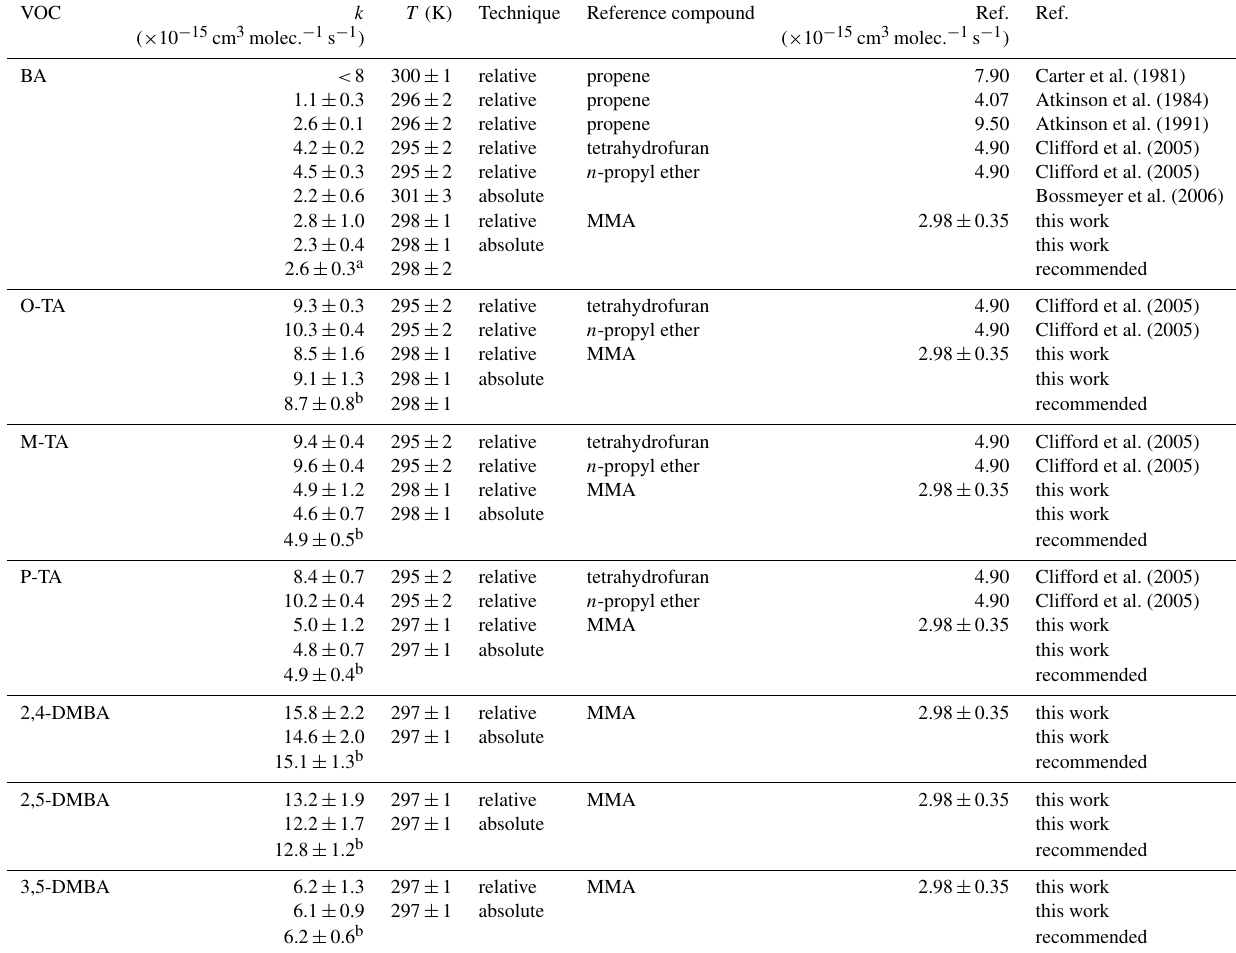
Table 2. Experimental results of this study compared with those from the literature for the reactions of the NO 3 radical with ben- zaldehyde (BA), o -tolualdehyde (O-TA), m -tolualdehyde (M-TA), p -tolualdehyde (P-TA), 2,4-dimethylbenzaldehyde (2,4-DMBA), 2,5- dimethylbenzaldehyde (2,5-DMBA) and 3,5-dimethylbenzaldehyde (3,5-DMBA). VOC k T (K) Technique Reference compound